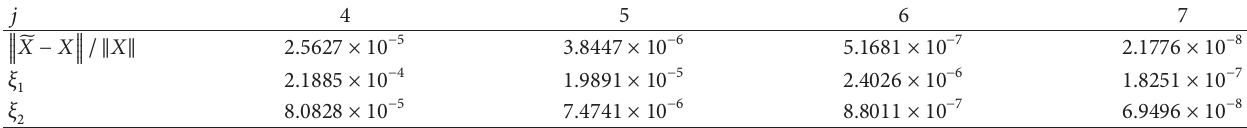
Table 2: Perturbation bounds for Example 15 with different values of 𝑗 .